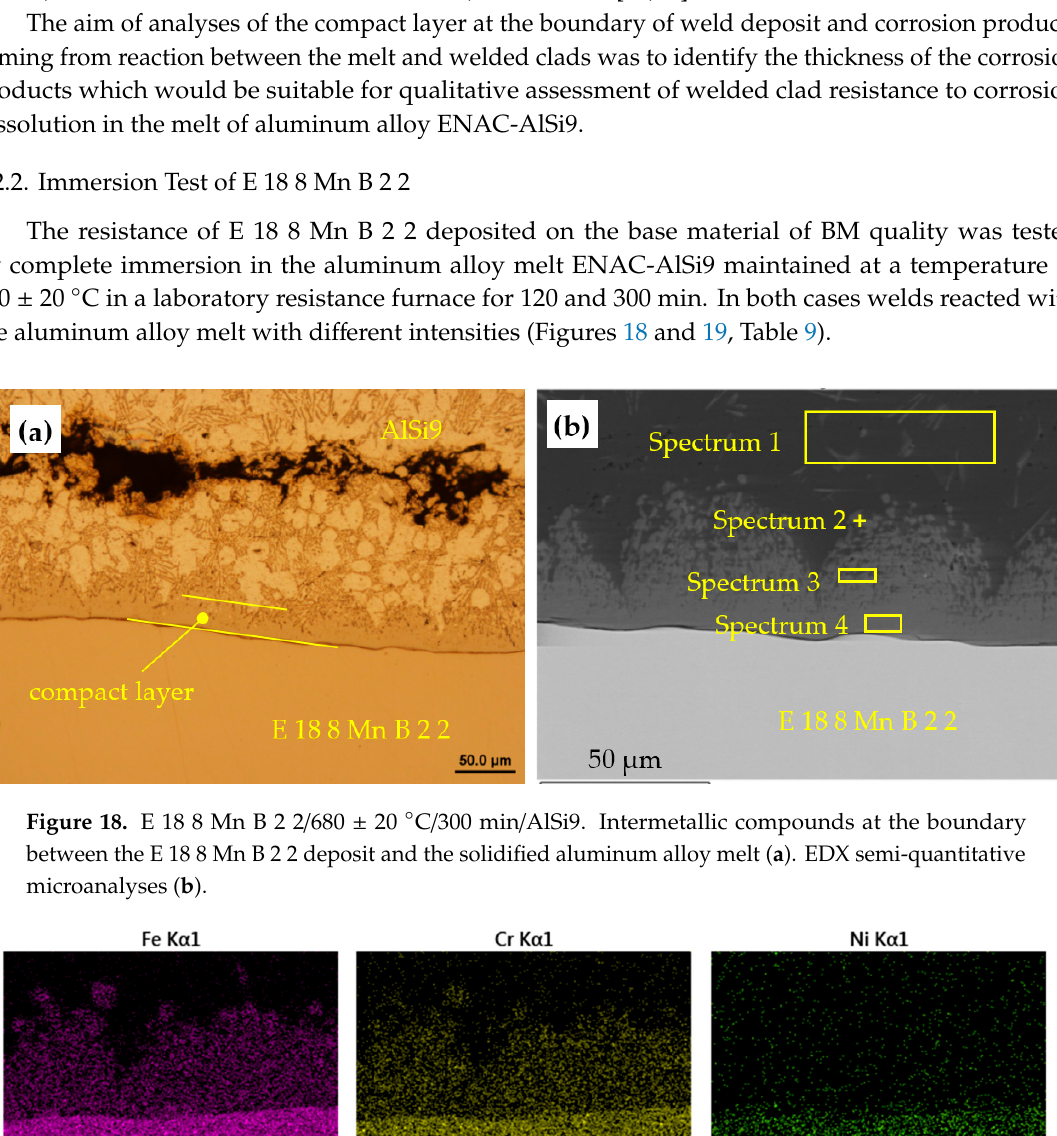
/ 680 ± 20 ◦ C / 120 min / AlSi9. EDX semi-quantitative microanalyses Figure 19. E 18 8 Mn B 2 2/680 ± 20 °C/120 min/AlSi9. EDX semi-quantitative microanalyses (mapping). Figure 19. E 18 8 Mn B 2 2